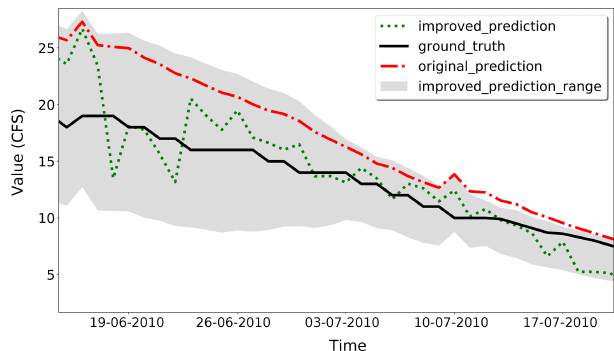
Figure 11. Case Study 1, final PRMS model streamflow prediction improvements. The improved predictions are closer to the ground truth than the original